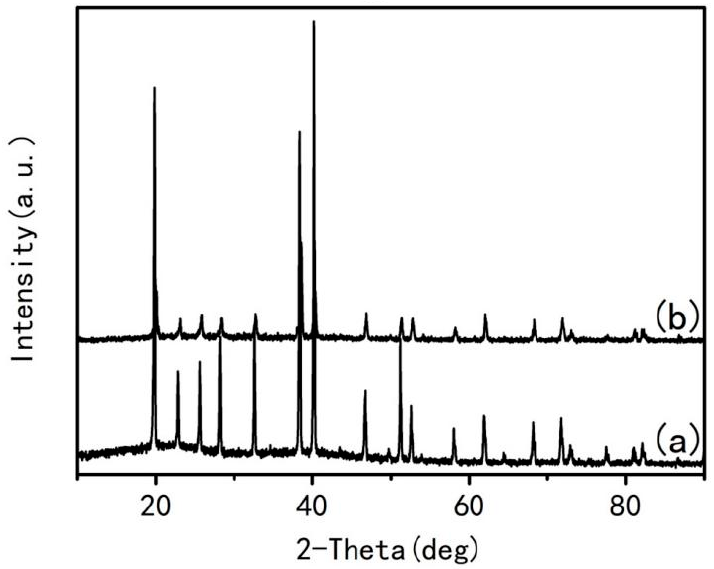
Figure 6. XRD spectra of gels under different conditions: ( a ) before foam; ( b ) before combustion reaction .